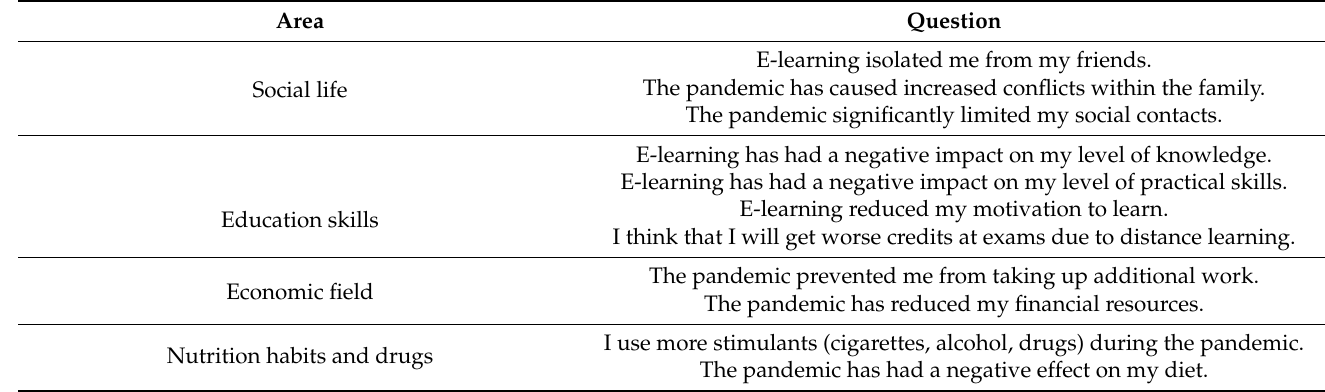
Table 1. Authors’ survey areas and